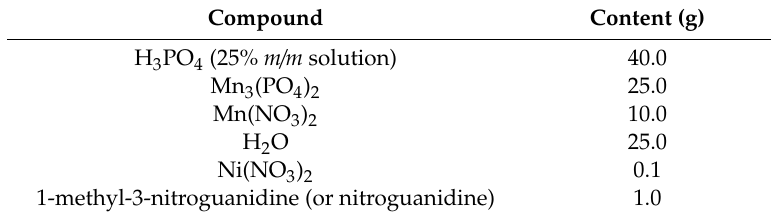
Table 3. Chemical Composition of concentrated solution for manganese phosphate process [8].